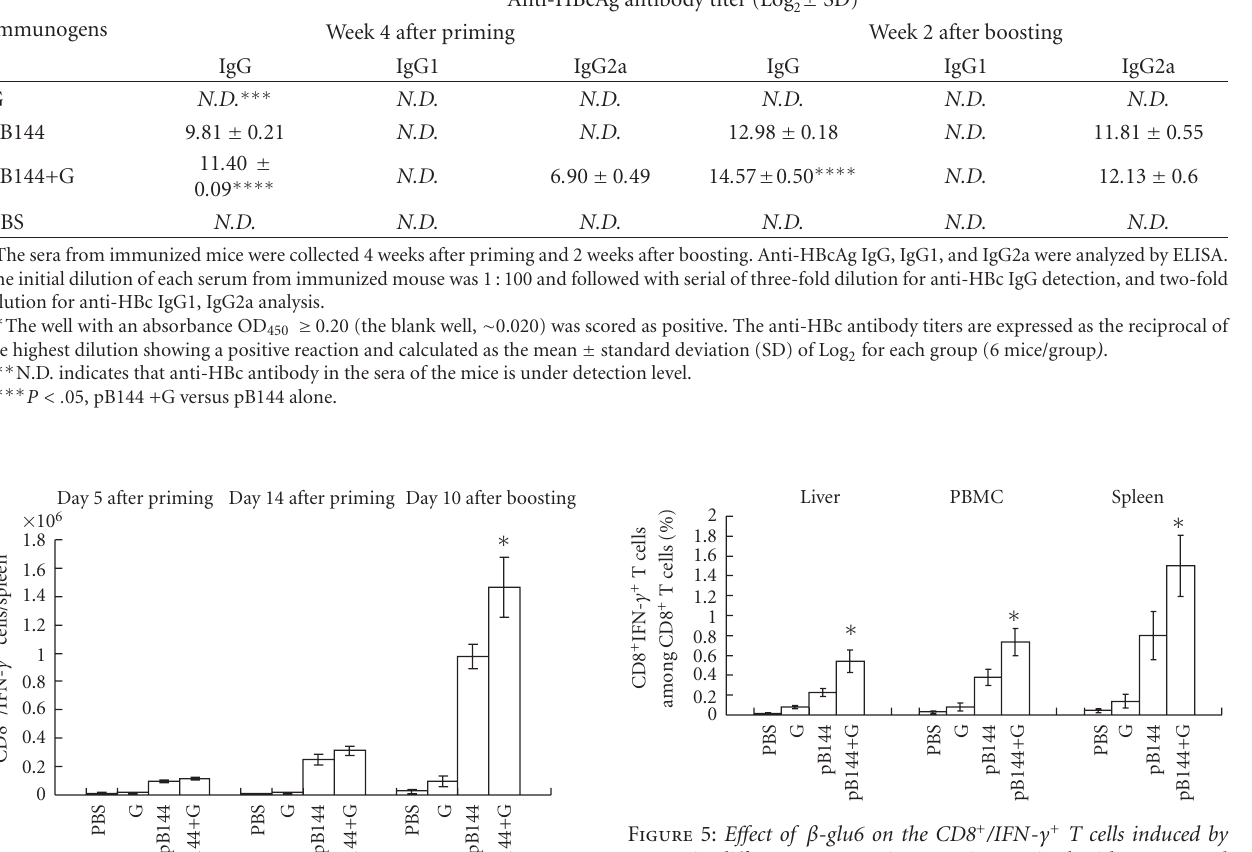
Table 1: E ff ect of β -glu6 on pB144-induced antibody production ∗ . Immunogens